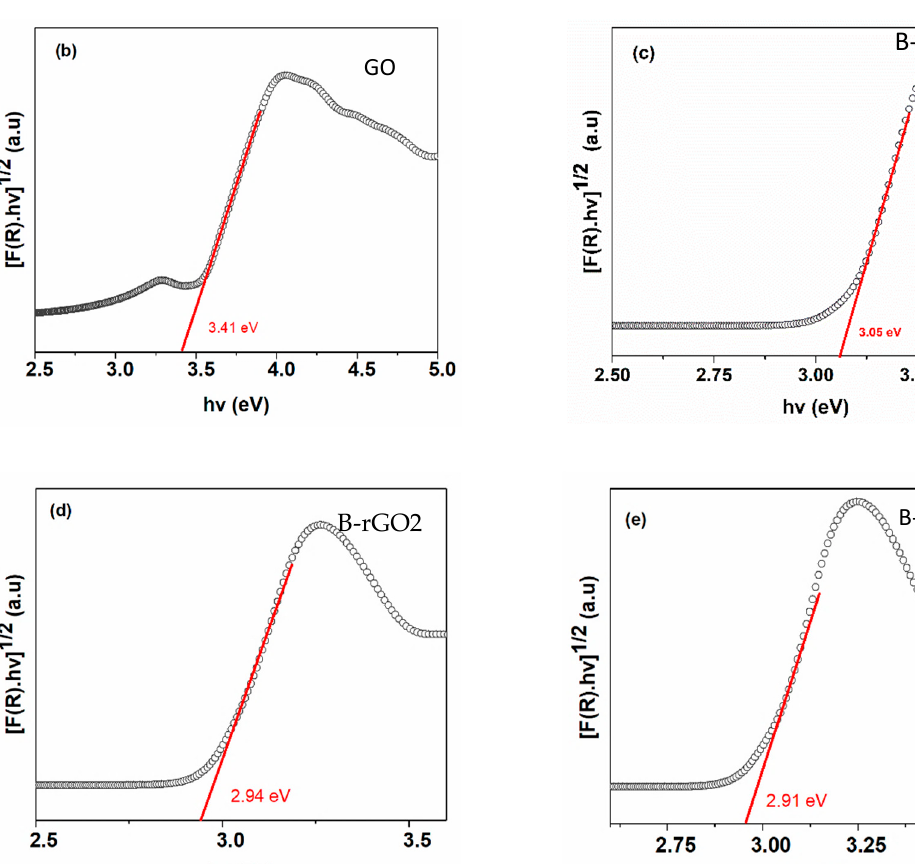
Figure 5. ( a ) UV-Vis absorption spectra of GO and B-rGO samples ( b )–( e ) Tauc plot for the GO, and B-rGO1, B-rGO2, and B-rGO3 samples, respectively.